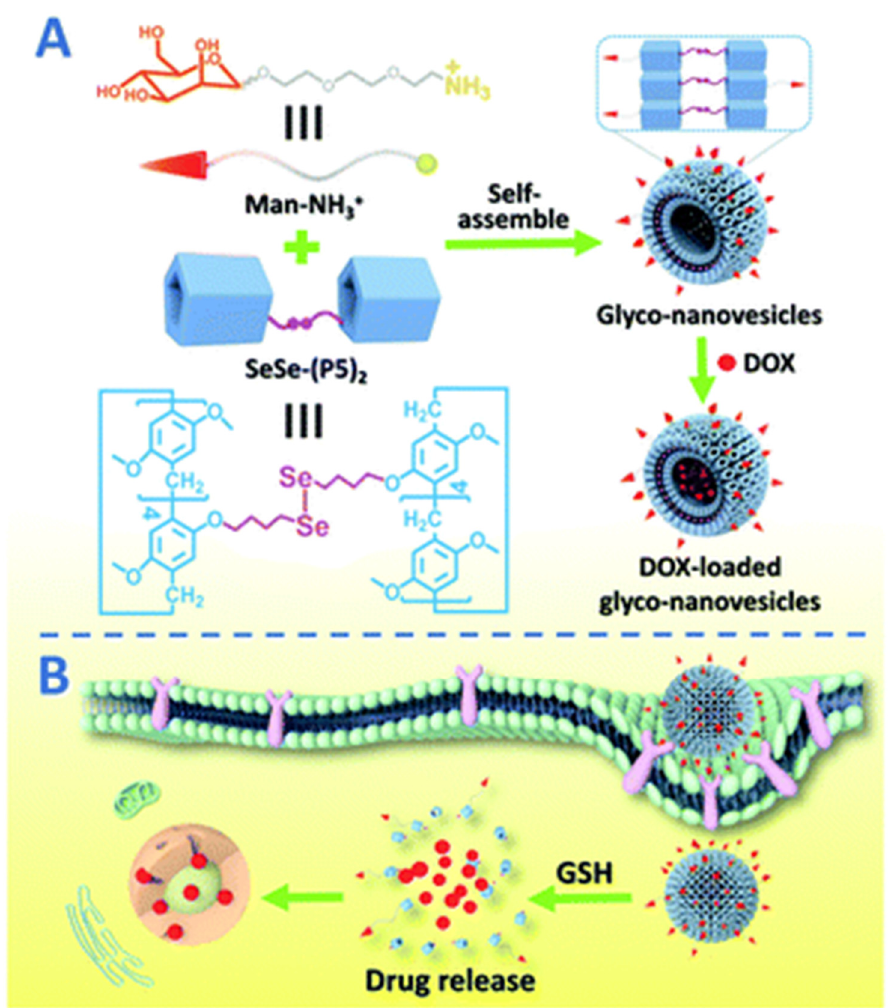
Figure 5. Schematic representation of ( A ) the construction of supramolecular glyco-nanovesicles “(SeSe-(P5)2 * Man-NH 3 ” and ( B ) their targeting chemotherapy. Reproduced with the permission of reference [82]. Copyright © Royal Society of Chemistry 2020.